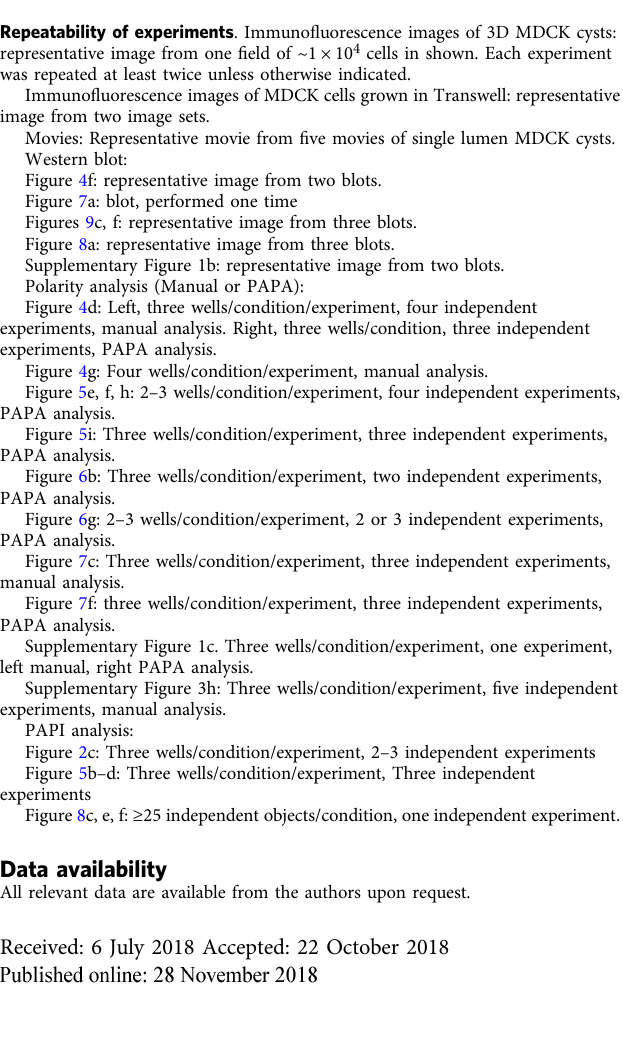
Western blot: Figure 4f: representative image from two blots. Figure 7a: blot, performed one time Figures 9c, f: representative image from three blots. Figure 8a: representative image from three blots. Supplementary Figure 1b: representative image from two blots. Polarity analysis (Manual or PAPA): Figure 4d: Left, three wells/condition/experiment, four independent experiments, manual analysis. Right, three wells/condition, three independent experiments, PAPA analysis. Figure 4g: Four wells/condition/experiment, manual analysis. Figure 5e, f, h: 2 – 3 wells/condition/experiment, four independent experiments, PAPA analysis. Figure 5i: Three wells/condition/experiment, three independent experiments, PAPA analysis. Figure 6b: Three wells/condition/experiment, two independent experiments, PAPA analysis. Figure 6g: 2 – 3 wells/condition/experiment, 2 or 3 independent experiments, PAPA analysis. Figure 7c: Three wells/condition/experiment, three independent experiments, manual analysis. Figure 7f: three wells/condition/experiment, three independent experiments, PAPA analysis. Supplementary Figure 1c. Three wells/condition/experiment, one experiment, left manual, right PAPA analysis. Supplementary Figure 3h: Three wells/condition/experiment, fi ve independent experiments, manual analysis. PAPI analysis: Figure 2c: Three wells/condition/experiment, 2 – 3 independent experiments Figure 5b – d: Three wells/condition/experiment, Three independent experiments Figure 8c, e, f: ≥ 25 independent objects/condition, one independent experiment. Data availability All relevant data are available from the authors upon